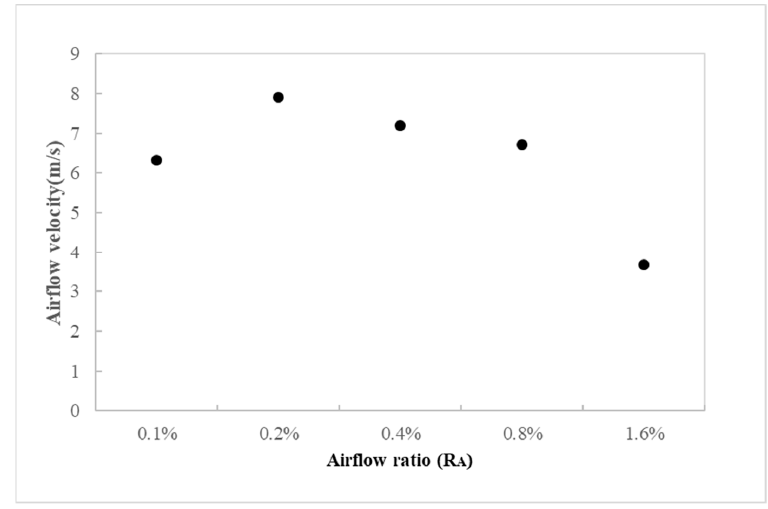
Figure 9. Average velocity of air flow corresponding to the area ratio.